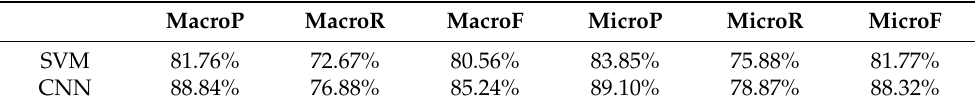
Table 3. Model comparison results.